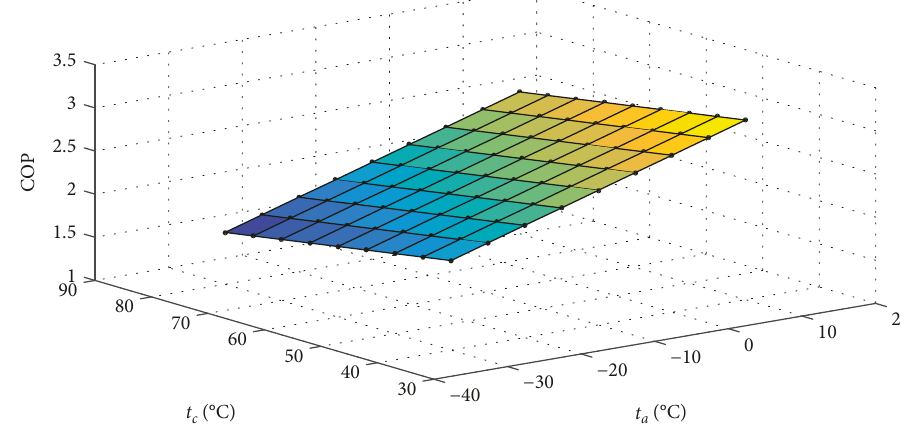
Figure 4: COP of the CO